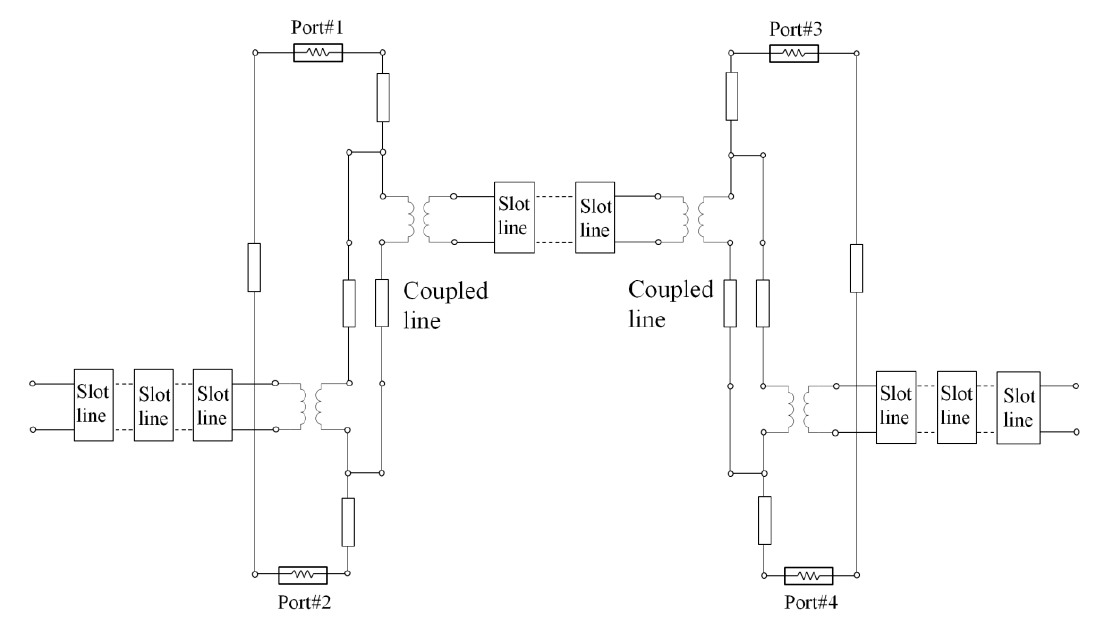
Figure 6. Crosstalk equivalent circuit of the meander split on the ground plane.